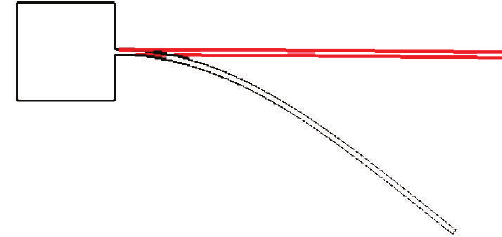
Figure 7: Comparison between deflections, v (cid:8) 0 . 27m/s, plate